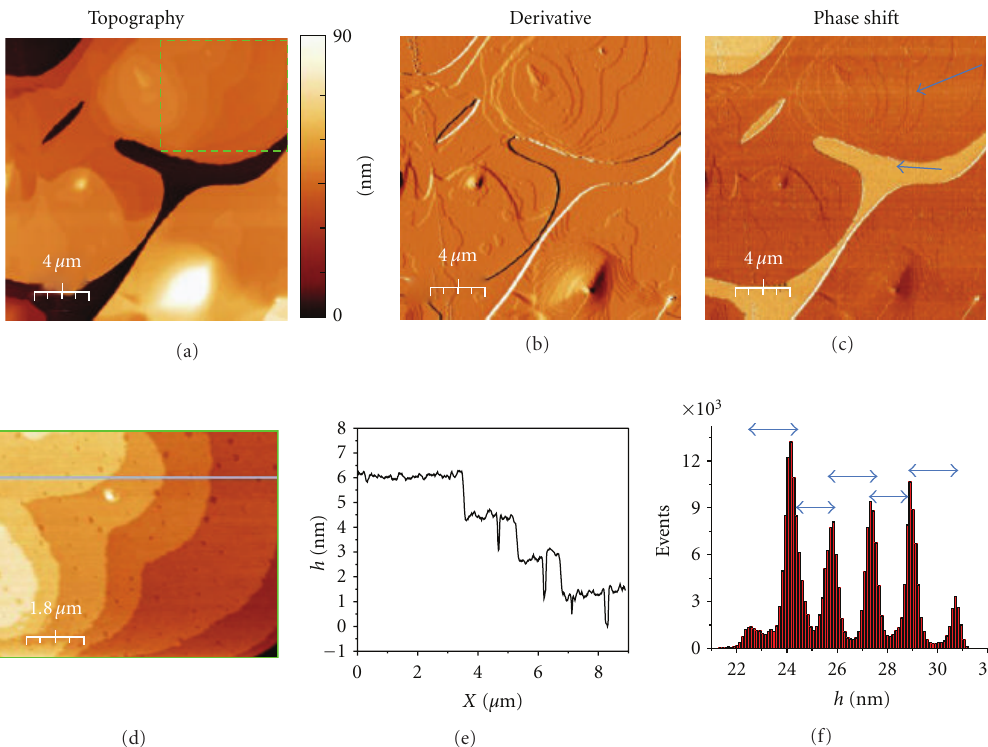
Figure 3: SFM data of a spray-deposited diF-TES ADT, partially covering the interelectrode device region. (a) Topographic image, (b) topography derivative image, (c) phase shift image, (d) magnification topography taken on the dotted area in (a). (e) Line profile taken along the blue segment in (d) crossing three single steps and some one-layer-deep vacancy defects. (f) Height histogram of image